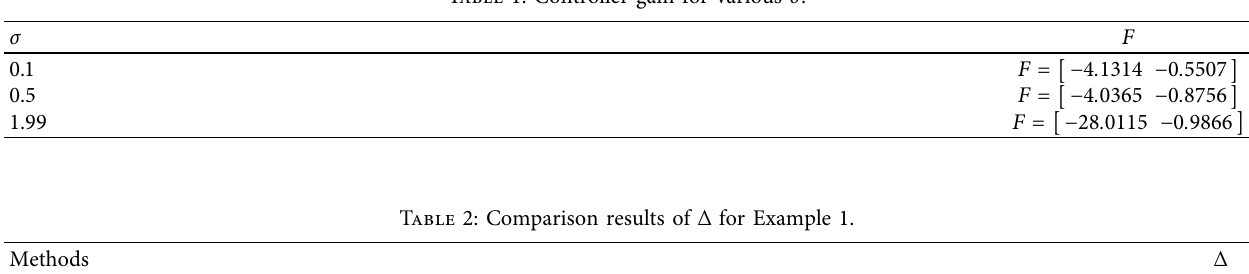
Figure 2: Behavior in the ξ Table 1: Controller gain for various σ .